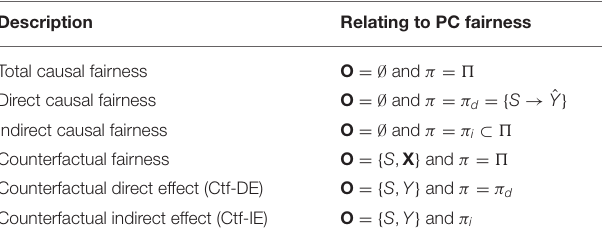
TABLE 2 | Connection between Path-specific Counterfactual Fairness (PC Fairness) and other fairness notions. Description